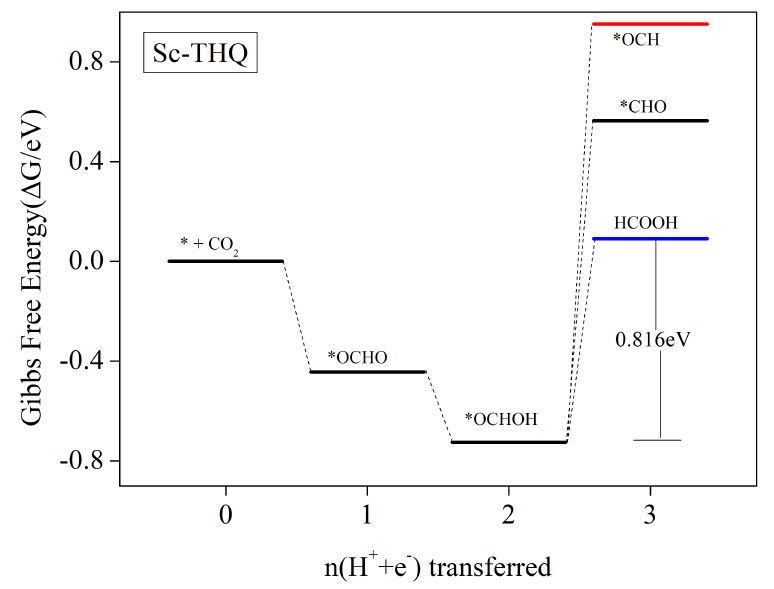
Figure 6. Gibbs free energy profile of CO 2 RR following the path of most favorable Zn-HAB at the zero potentiation. CO 2 molecules in the gaseous phase is given a free energy of zero on the clean catalytic